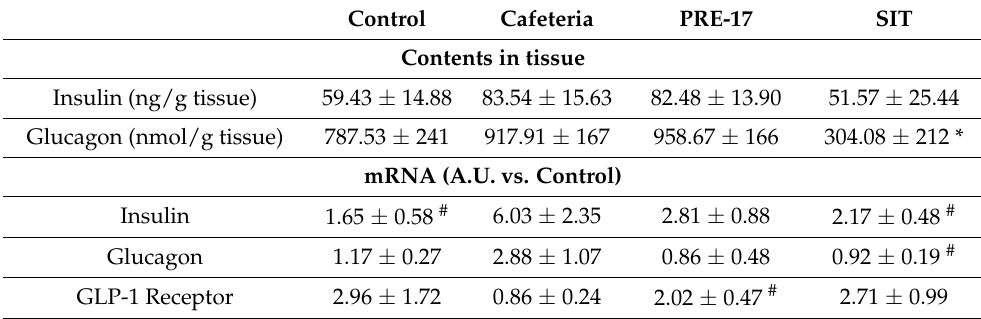
Table 3. Pancreas parameters for rats treated for 17 weeks with a cafeteria diet after a 10-day GSPE pre-treatment (PRE-17) or concomitant to a GSPE treatment every two weeks